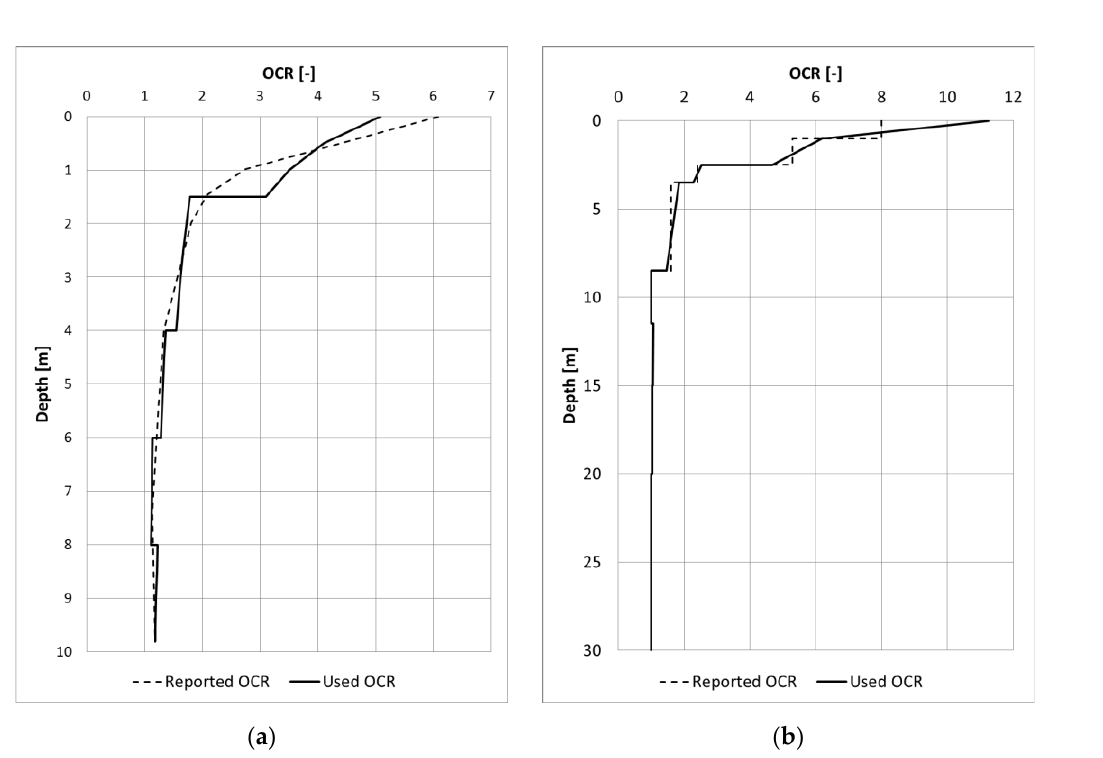
Figure 7. Variation of OCR with depth for Embankment A [6] ( a ) and Embankment B [8] ( b ). The values of the horizontal ( k h ) and vertical ( k v ) hydraulic conductivities were